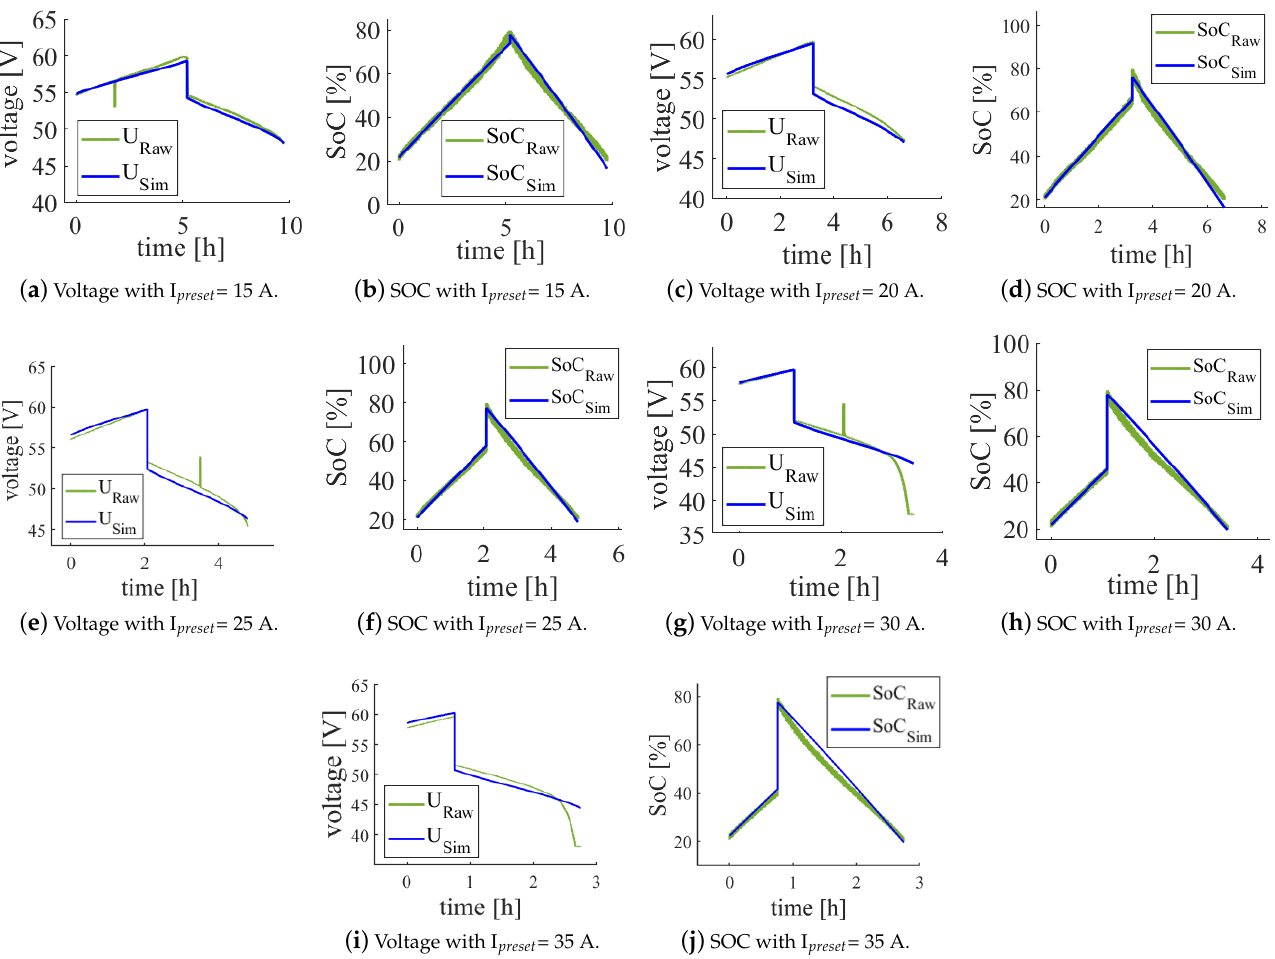
Figure 10. Comparison of raw data with simulation data with preset current I preset from 15 A to 35 A based on SOC and voltage with CV phase